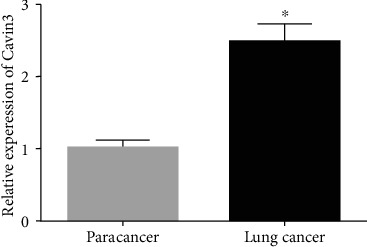
Differential expression of Cavin3 in lung cancer tissues and paracancer tissues. Note: N = 200, ∗ means p < 0.05.